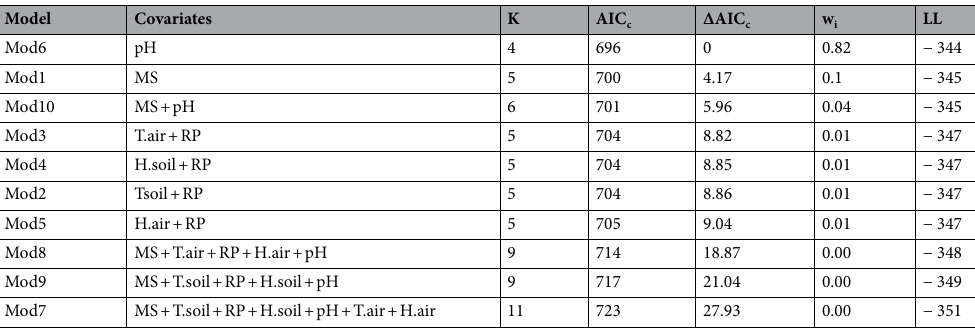
Table 6. Akaike statistics for model including the species richness, the management scenario and the environmental variables, AIC (Akaike’s Information Criterion) differences (ΔAICc) and Akaike weights (wi) were used to rank models relative to the best model (minimum AIC). K number of parameters, LL log likelihood.